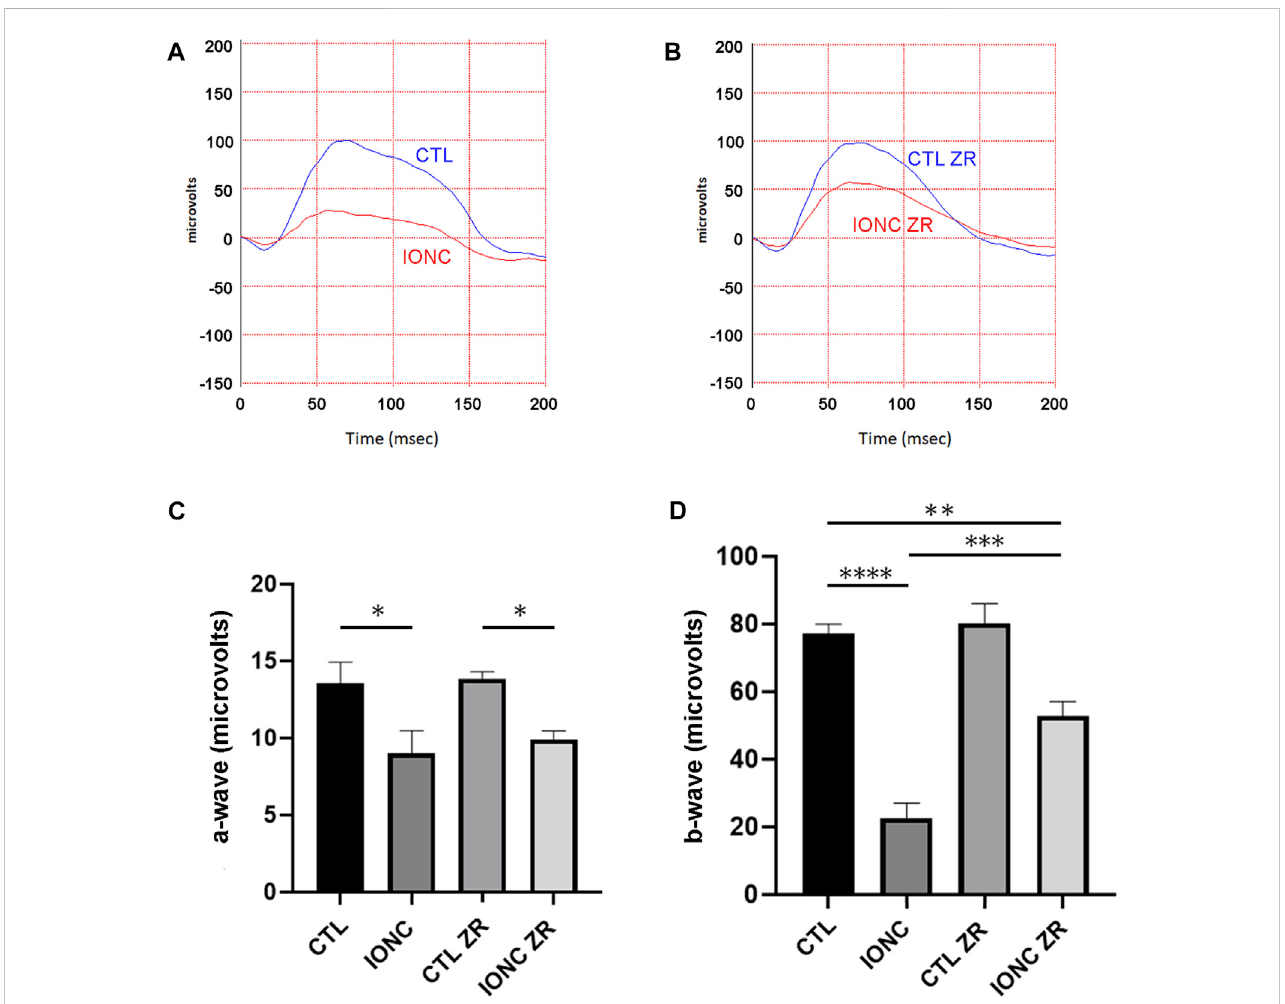
FIGURE 2 Electroretinograms and quanti fi cation of the a- and b-waves on the four experimental groups. Representative electroretinograms of vehicle- (A) and zr17-2-treated (B) animalssubjectedtoIONC(redlines)orsham-operated(bluelines).Thea- (C) andb-waves (D) werequanti fi ed.Barsrepresentthemean± SD of all animals ( n = 9 per experimental group). Asterisks represent statistically signi fi cant differences (ANOVA). *: p < 0.05; **: p < 0.01; ***: p < 0.001; ****: p <